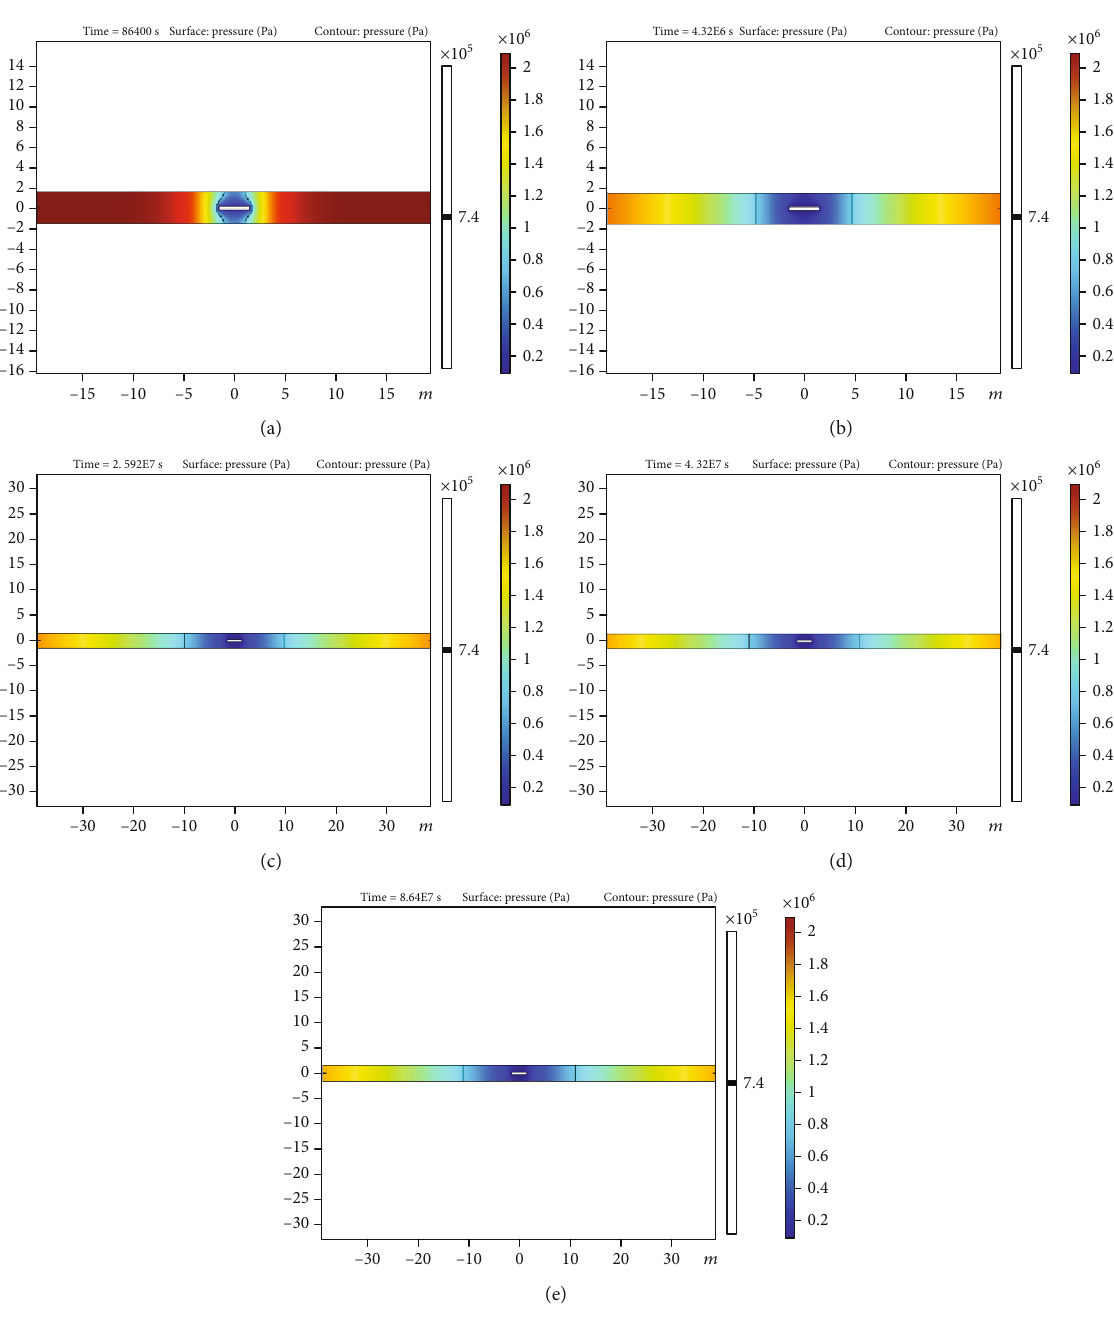
Figure 8: Methane pressure after di ff erent extraction times: (a) 1 day, (b) 50 days, (c) 300 days, (d) 500 days, and (e) 1000